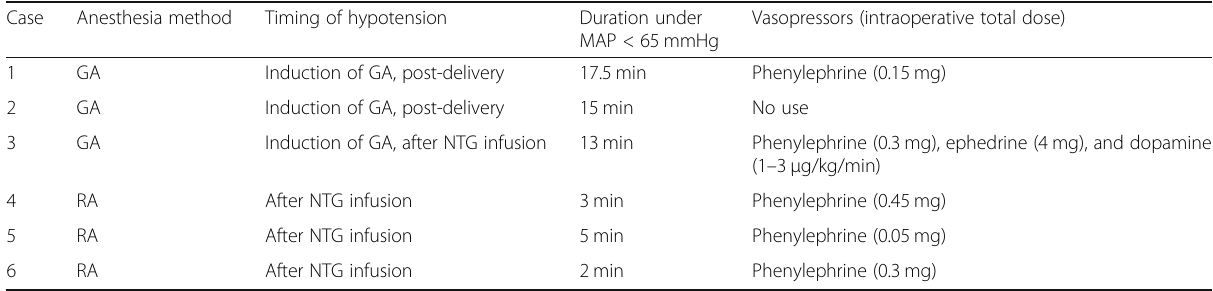
Table 3 Data for patients with intraoperative MAP < 65